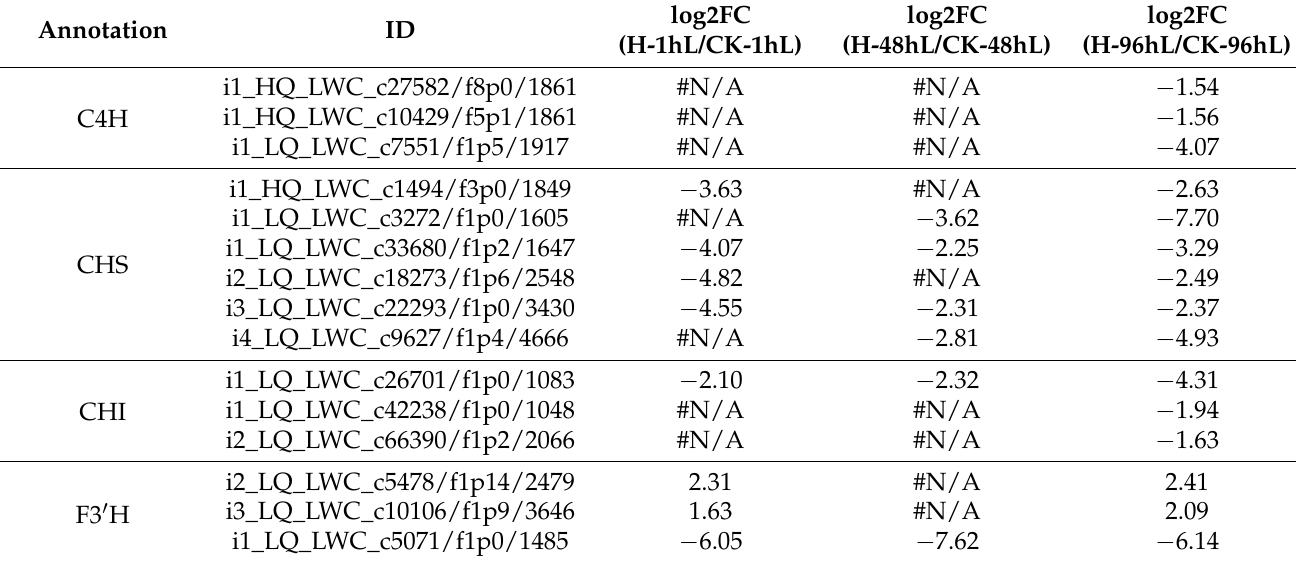
Table 4. Expression of Flavonoid Biosynthesis Related Genes in Pearl Millet Leaves under Heat Stress for 96 h.